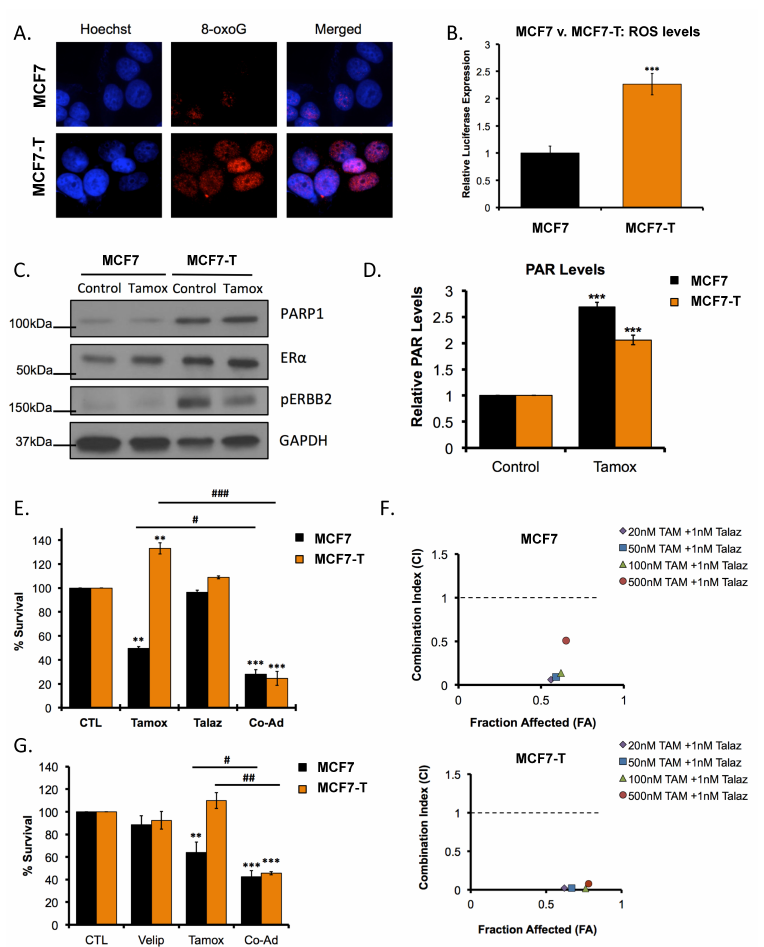
Figure 1. Therapeutic inhibition of PARP1 promotes sensitivity to tamoxifen treatment, in ER+ breast cancer, scale bar: 20 µ m. ( A ) Immunofluorescence staining of 8-hydroxyguanosine (8-oxoG) in MCF7 and MCF7-T cell lines. ( B ) Basal ROS levels in MCF7 compared MCF7-T cells. Quantification is representative of at least three individual experiments. ( C ) MCF7 and MCF7-T cells were treated for 24 h with 100 nM tamoxifen (Tamox) and western blot analysis performed against the indicated antibodies. ( D ) MCF7 and MCF7-T cells were treated with Tamox (24 h, 100 nM) and subjected to PAR ELISA ( E ) MCF7 and MCF7-T cells were treated with 100 nM Tamox or 1 nM Talaz for 72 h, alone and in combination, and colony formation assay was performed. ( F ) MCF7 (Top) and MCF7-T (Bottom) cells were treated with Tamox and Talaz for 72 h, alone and in combination, and subjected to clonogenic survival assay to determine drug efficacy; x-axis is indicative of Fraction affected (FA), y-axis is indicative of the combination index (CI). Combinations beneath the black dashed line are synergistic. Results are representative of three independent experiments. ( G ) MCF7 and MCF7-T cells were treated with 100 nM Tamox or 10 nM veliparib (Velip) for 72 h, alone and in combination, and colony formation assay was performed. PAR, Poly (ADP-ribose). ** p < 0.001, *** p < 0.0001 compared to control, # p < 0.01, ## p < 0.001, ### p < 0.0001 relative to bracketed